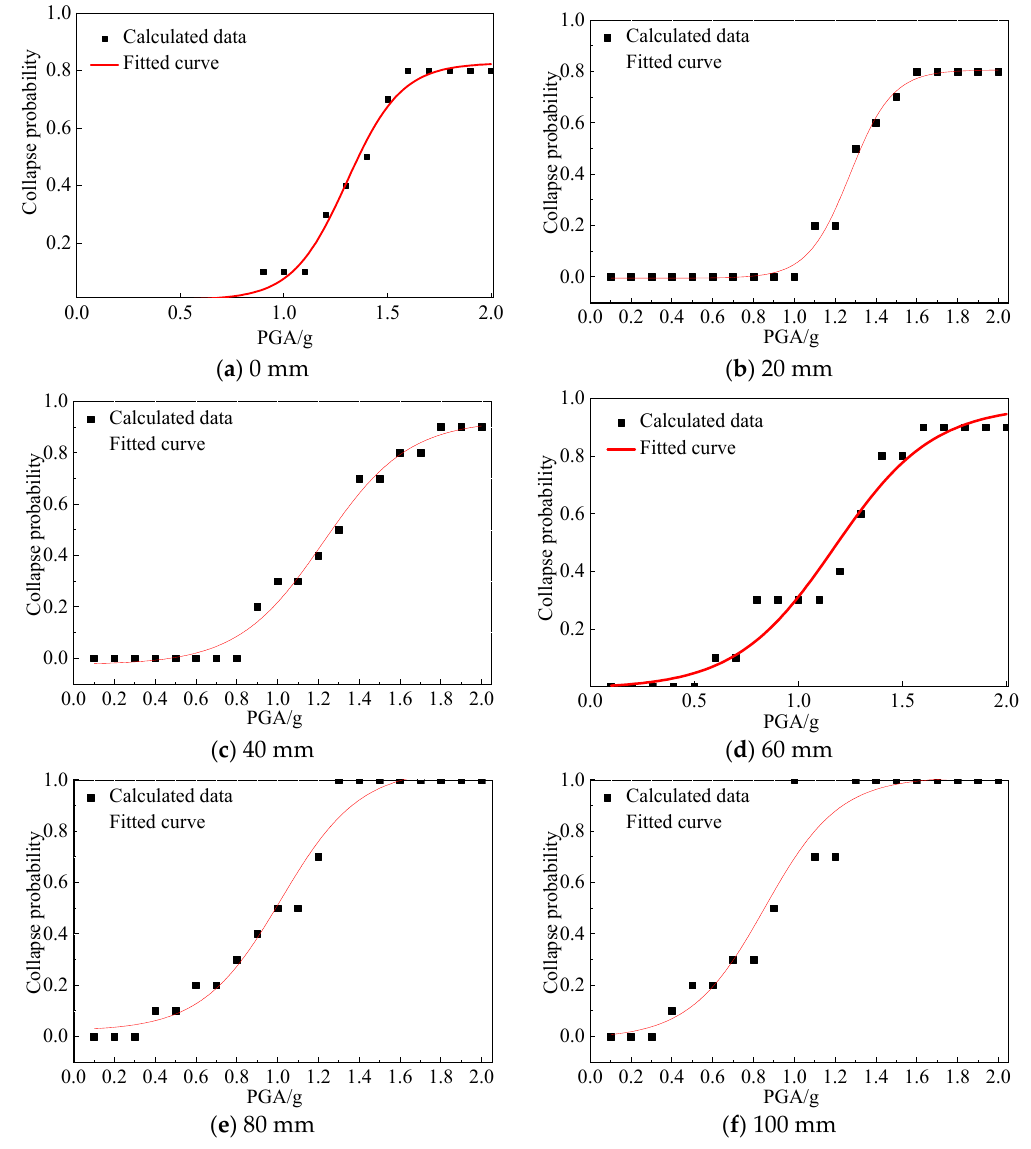
Figure 6. Collapse probabilities of structures with different uneven settlement quantities in Zone I.